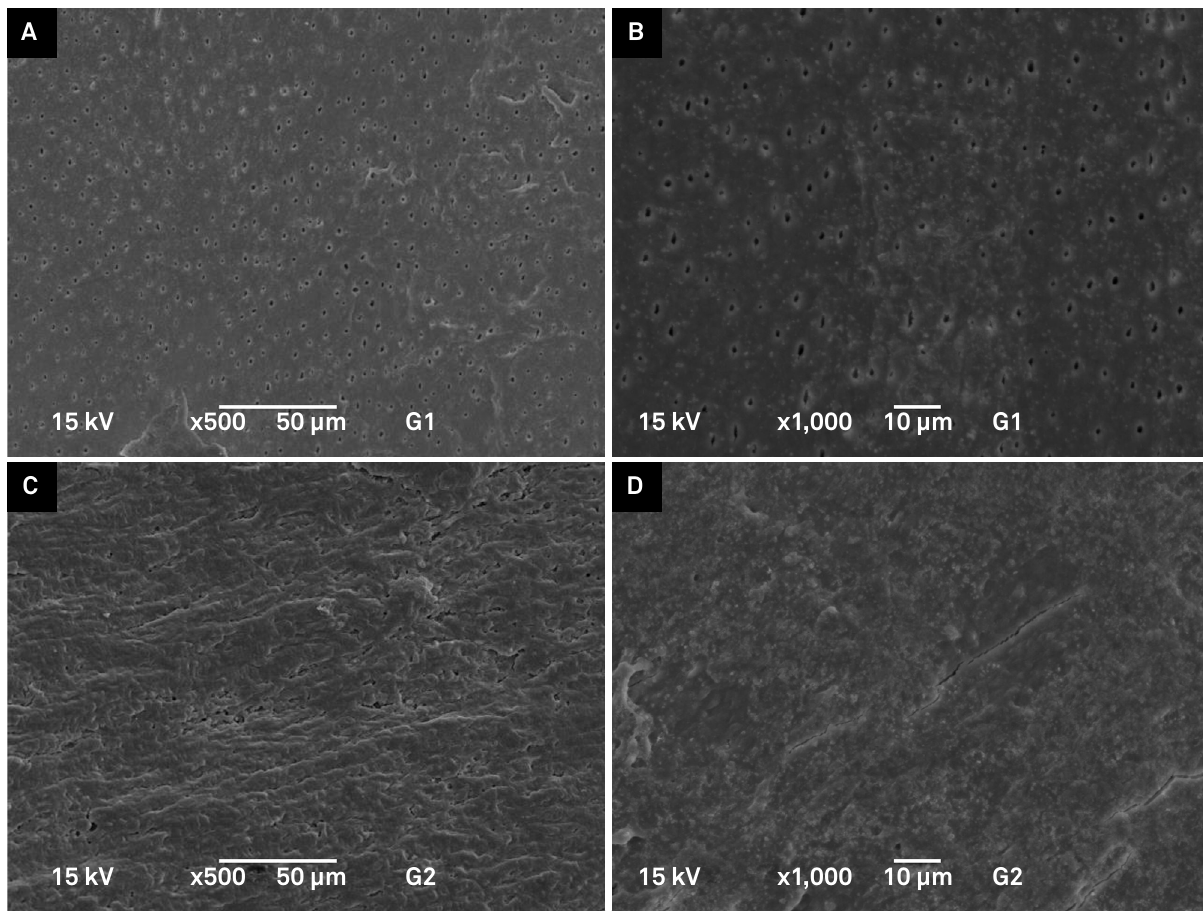
Figure 1. SEM representative image of samples from groups 1 (A and B) and 2 (C and D). Note that in A and B, the dentinal tubules are open, while in C and D, the tubules of the irradiated dentin are not visible. Magnification of 500× (A and C) and 1000× (B and